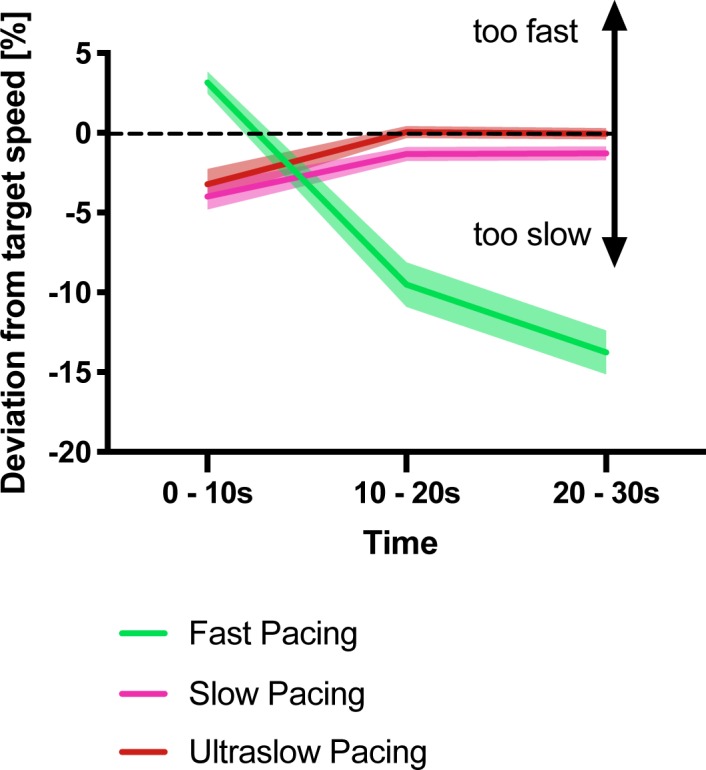
Deviation from the target speed in the pacing experiment shown in Figure 1B.During the first 10 s, participants slightly underpaced during the slow and ultraslow conditions whereas they overpaced during the fast condition. This error diminished for the two slower conditions reflecting that participants complied well with the target speed. However, for the fast pacing condition, deviation from the target speed increased over time reflecting gradual motor slowing. All values mean ± sem.